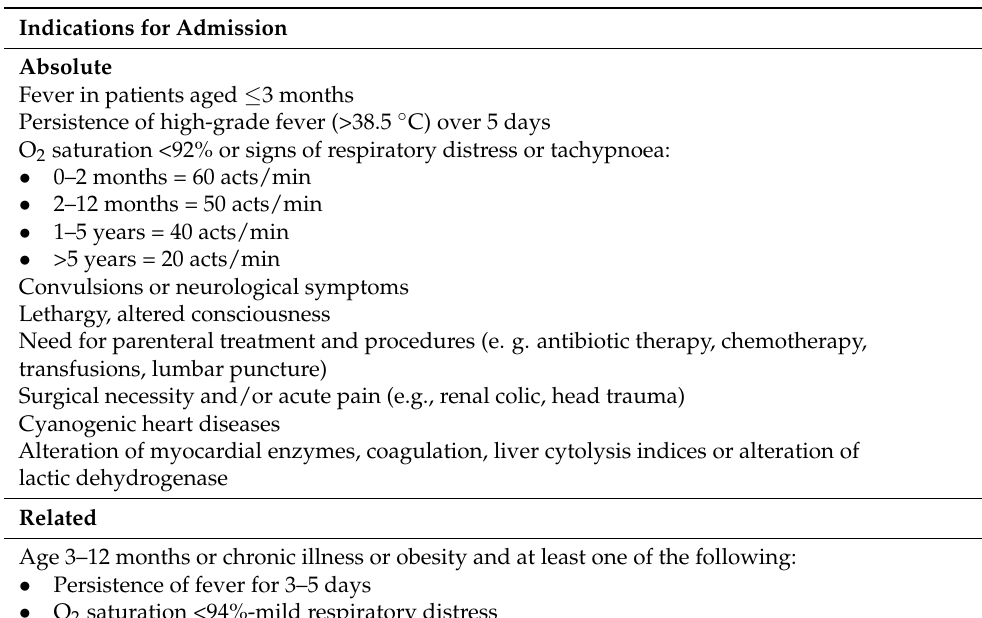
Table 2. Indications for